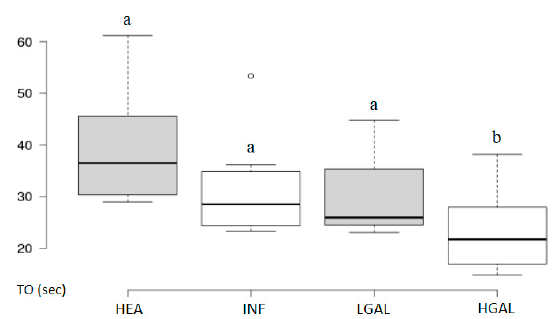
Figure 7. Box and whisker plot of the falling time (FT) for healthy (HEA), inflammatory (INF), low-grade alimentary lymphoma (LGAL) and high-grade alimentary lymphoma (HGAL). a,b Values with different superscript letters differ significantly ( p < 0.05).